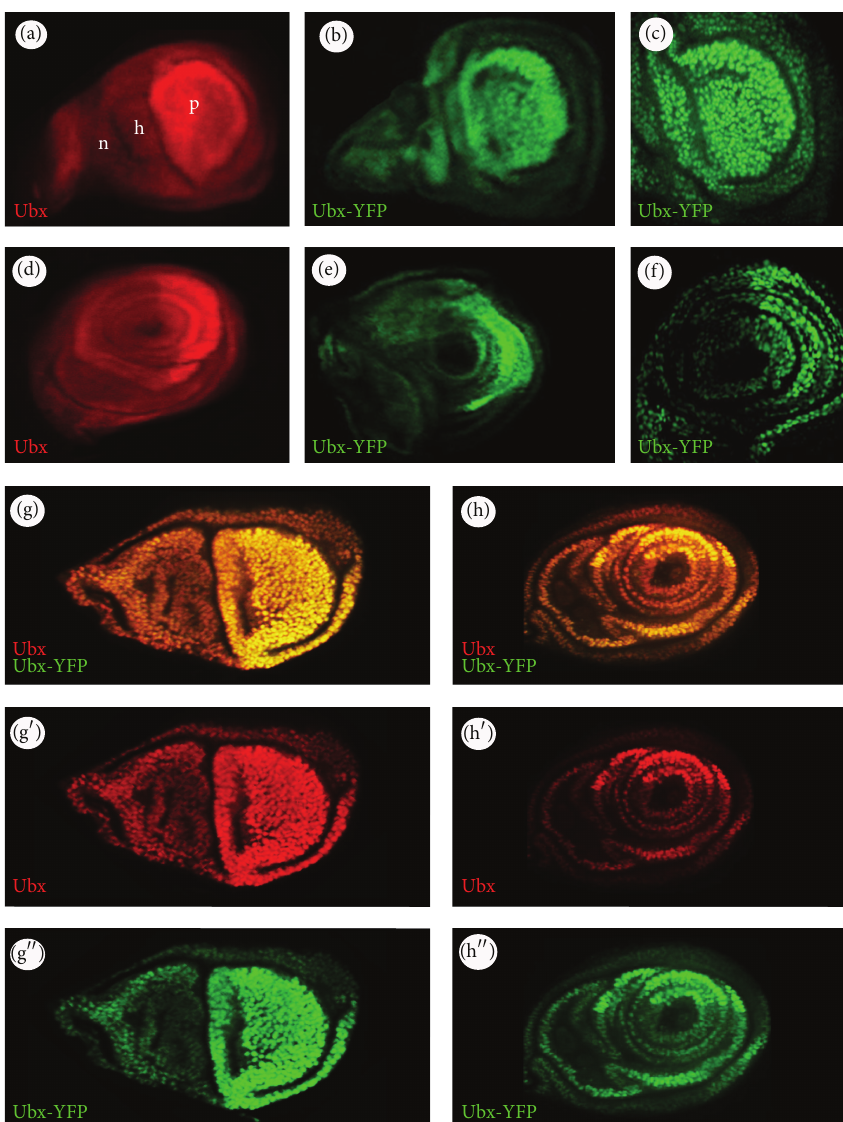
Figure 3: The patterns of Ubx expression in the T3 haltere and leg discs. (a) The expression patterns of endogenous Ubx in T3 haltere: p = pouch,h=hinge,andn=notum.(b)TheexpressionpatternofUbx-YFPinhaltereand(c)athighermagnification.(d)Theexpressionpatterns of the endogenous Ubx in T3 leg disc. (e) The expression pattern of Ubx-YFP in T3 leg disc and (f) at higher magnification. The expression pattern of Ubx-YFP at high magnification shows that the protein trap is nuclear. Double staining of the Ubx-YFP and its endogenous protein using 𝛼 -GFP and 𝛼 -Ubx, respectively, in the Ubx CPTI000601 haltere ((g)–(g 󸀠󸀠 )) and T3 leg ((h)–(h 󸀠󸀠 )) imaginal discs shows that they have very similar temporal and spatial expression